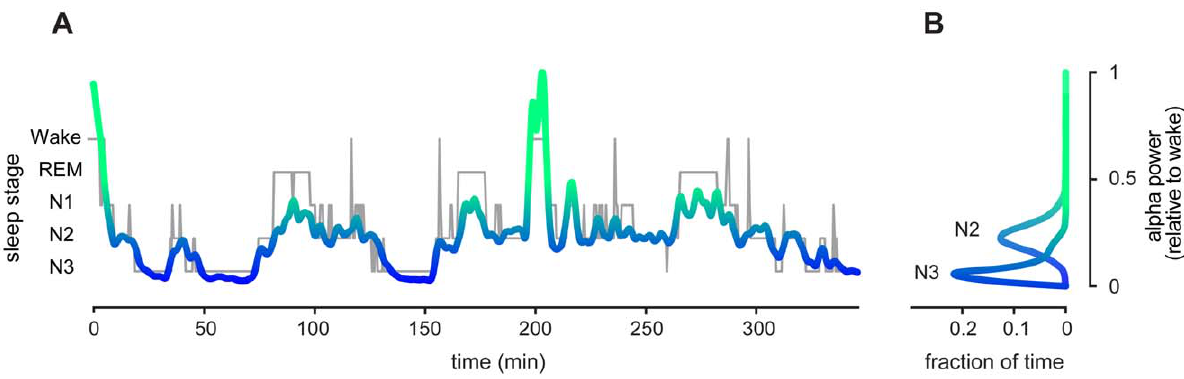
Figure 1. Alpha power fluctuates dynamically throughout the night. A. The trajectory of relative alpha power throughout a quiet night of sleep is shown from one representative subject. Simultaneous sleep stage designations run beneath the time course of alpha power. Diminishing as sleep begins, alpha power fluctuates throughout the night, in tandem with sleep depth. For display, the alpha power time-series was approximated using local linear regression in 4 minute windows, corresponding to the approximate length of each stimulation series (see Materials and Methods). This procedure removes noise and emphasizes slower fluctuations with fewer distortions than those imposed by simple low-pass filtering [42]. B. These histograms show the distribution of alpha power during NREM sleep, revealing that a range of values can be observed within each of stages N2 and N3. Power was computed in non-overlapping 10-second bins; epochs containing arousals, which may represent transient departures from stable sleep, were discarded.